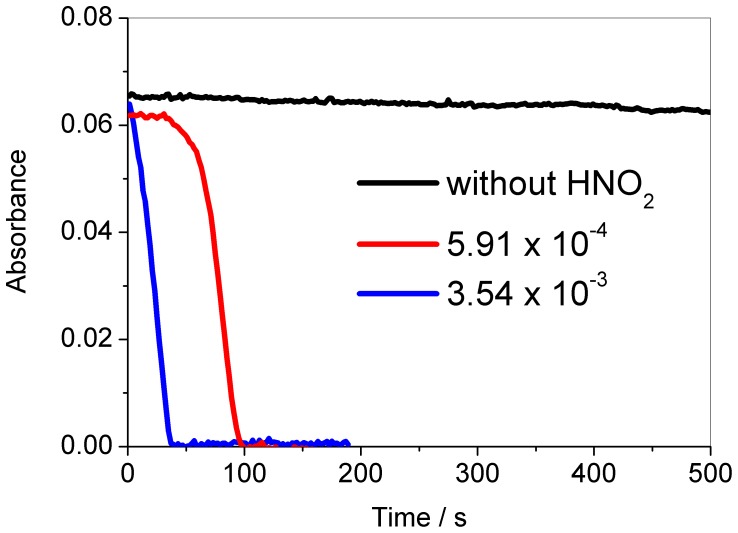
The addition of nitrous acid produces the chlorate-iodine-nitrous acid clock reaction.Following the absorbance at 460 nm for the systems chlorate-iodine-perchloric acid (without addition of HNO2) and chlorate-iodine-perchloric acid-nitrous acid (HNO2 concentrations indicated in the figure, mol L−1), both in the absence of ultraviolet light. Other initial concentrations: [HClO4] = 0.948 mol L−1; [NaClO3] = 0.0251 mol L−1; [I2] = 8.80×10−5mol L−1. Experimental data point were measured at every 2 s.